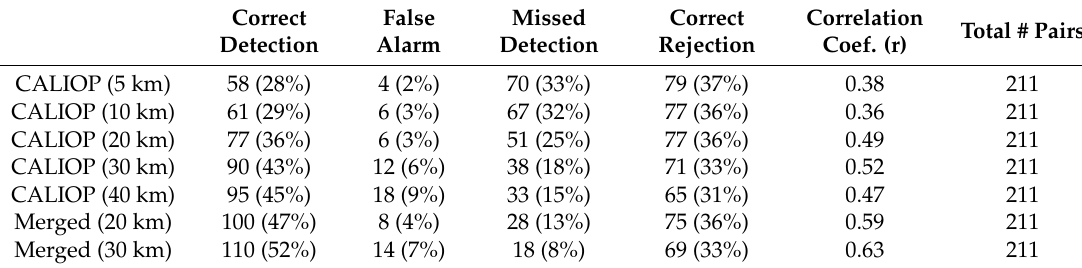
Table 4. Contingency tables and correlation coefficients (r) of ceilometer CBHs at KGEV and daytime satellite retrieved CBHs using the following products: averaged CALIOP Level 2 cloud layer product (333-m CBHs) at 5-, 10-, 20-, 30-, and 40-km horizontal scale; merged CALIOP-CPR CBHs using 20- and 30-km averaging scales for the CALIOP data, following the method outlined in Figure 2. Values in parentheses are expressed as a percentage of the total number of observation pairs (last column of the table). Note the 20-min window centered over the satellite overpass time is applied to obtain the matched ceilometer CBHs at